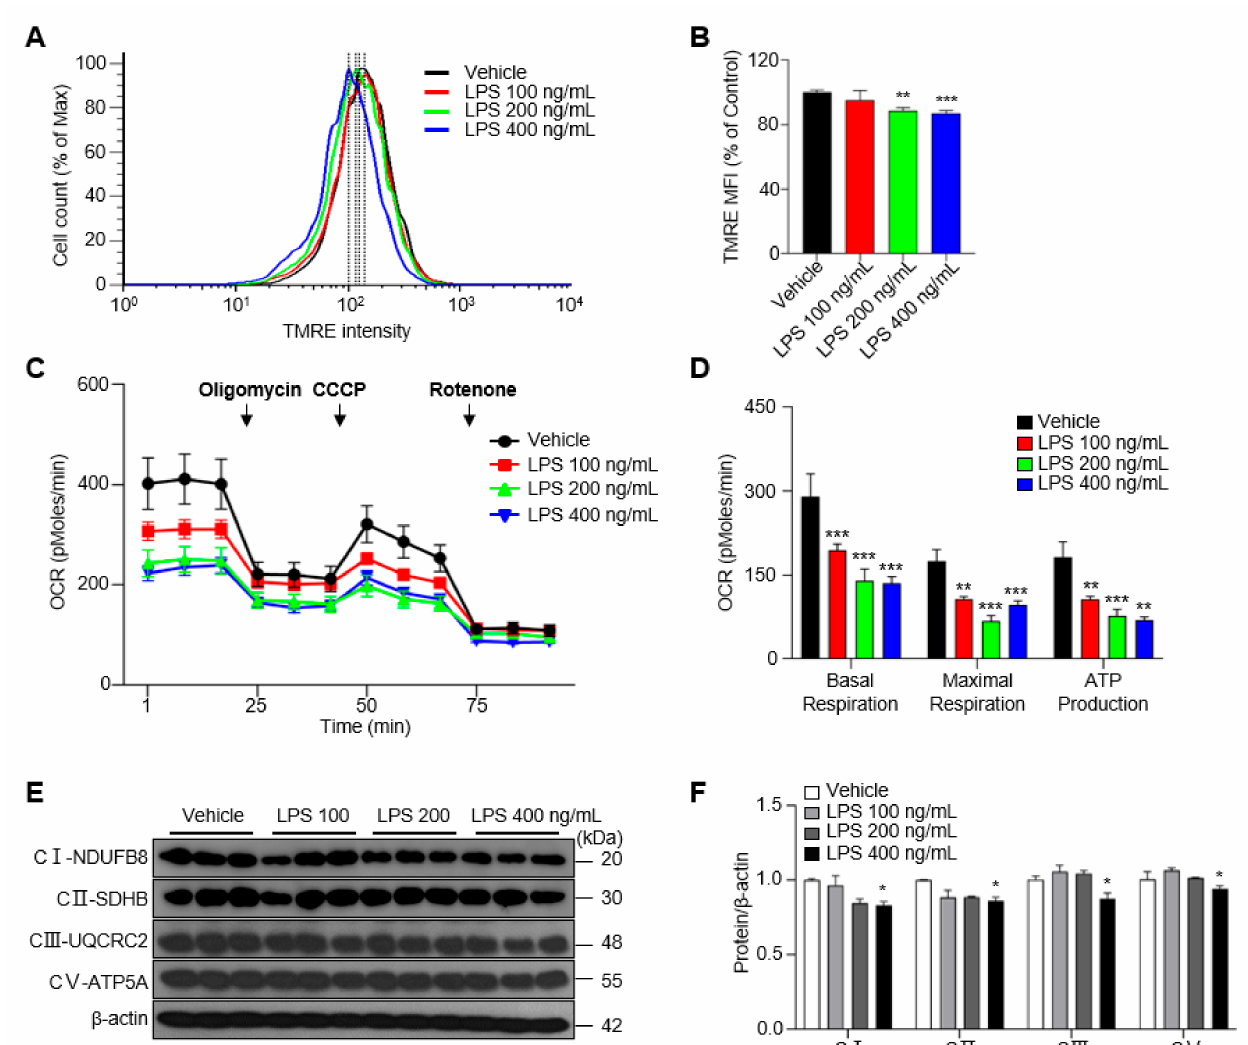
Figure 2. Treatment of LPS decreases the mitochondrial membrane potential (MMP) and mito- chondrial respiration in BV-2 cells for 48 h. ( A ) The MMP determined by TMRE-stained BV-2 cells. ( B ) Median fluorescence intensity (MFI) values as analyzed by the FlowJo program. ( C ) Oxygen consumption rate (OCR) measured in BV-2 cells treated with vehicle or LPS at 48 h. ( D ) The basal respiration, maximal respiration, and ATP production calculated by means of XF24 analyzer software. ( E ) The expression of mitochondrial complexes I, II, III and V in LPS-treated BV-2 cells. ( F ) The intensity values of mitochondrial complexes are shown. Data are presented as mean ± SEM of three independent experiments (* p < 0.05, ** p < 0.01, *** p < 0.001 compared to